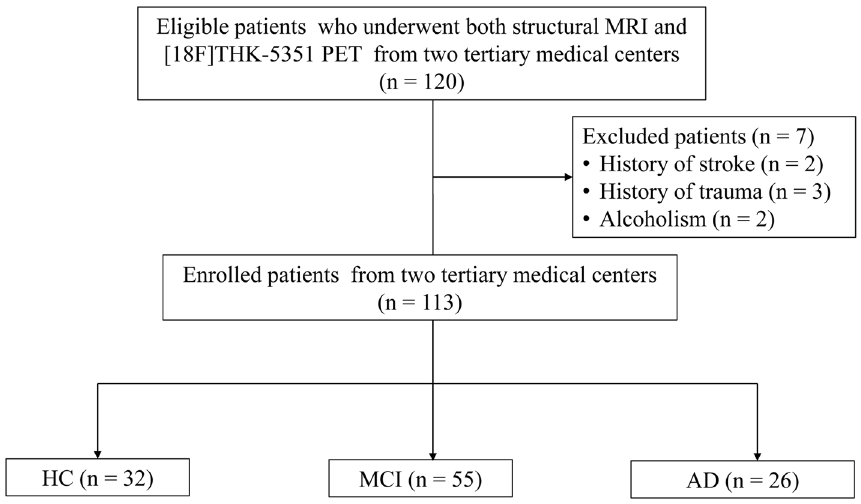
Figure 1. Flow diagram of the study